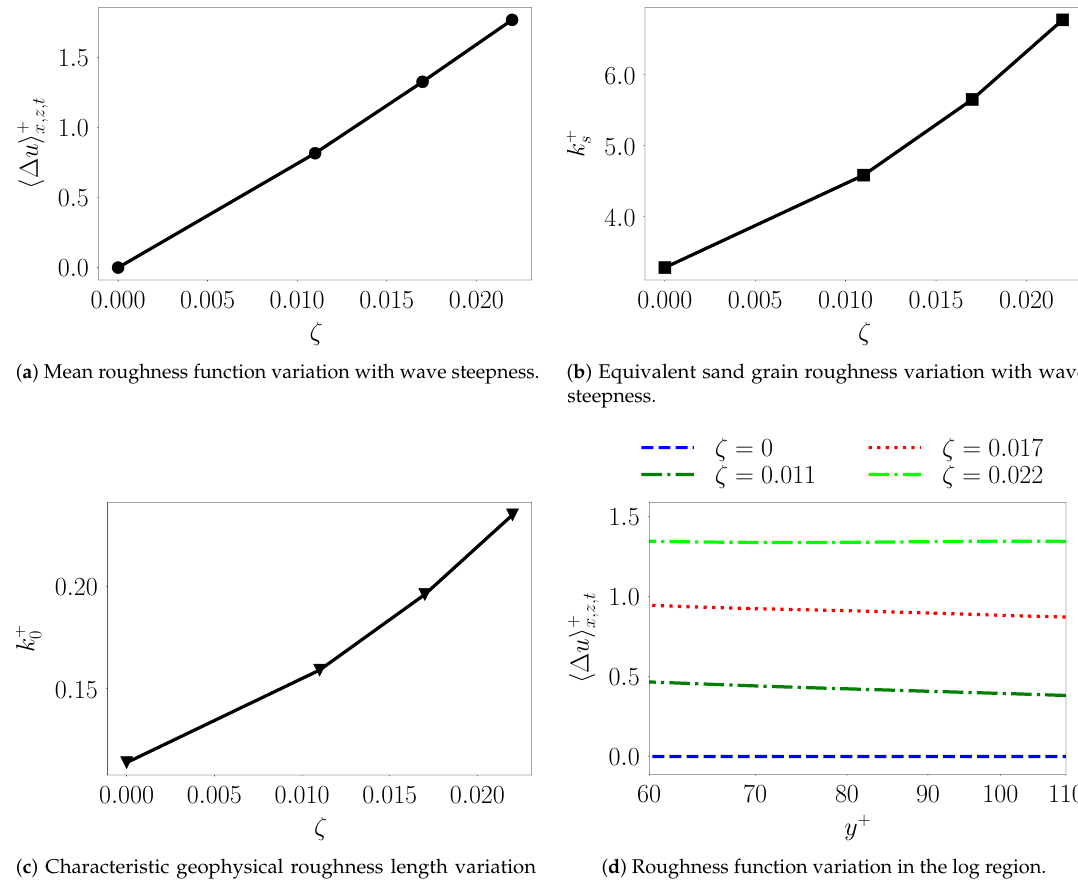
Figure 10. Variation of the different roughness quantifications with ζ ( a – c ) and wall normal variation of mean roughness function ( d